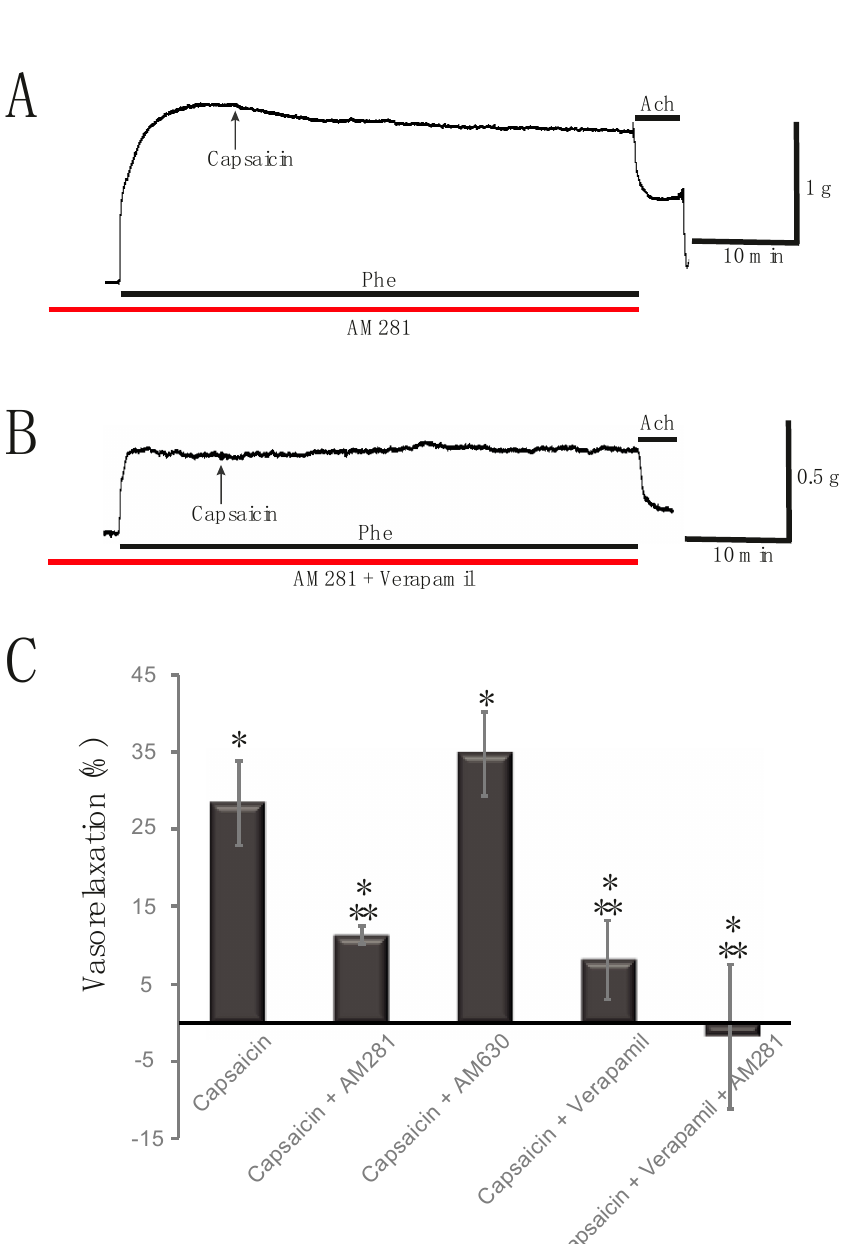
Figure 4. Effect of antagonists on Capsaicin-induced vasorelaxation. ( A ) Typical record showing that AM281 5 µM partially antagonizes the Capsaicin-induced vasorelaxant effect (11.32 ± 1.24 %; p < 0.01; n = 20 rings, 9 rats). ( B ) Representative trace showing that Verapamil and AM281 together prevent the vasorelaxant effect of Capsaicin causing slight vasoconstriction (1.80 ± 9.38 %; p = 0.85; n = 13 rings, 7 rats). The black line shows the exposure to Phe. Black arrows indicate the addition of Capsaicin. Red lines indicate exposure to each of the antagonists. ( C ) Summary of the action of antagonists on the vasorelaxant effect of Capsaicin. * indicates a significant change in tension compared to Phe pre-contraction. ** highlights a significant change compared to the effect of Capsaicin alone.